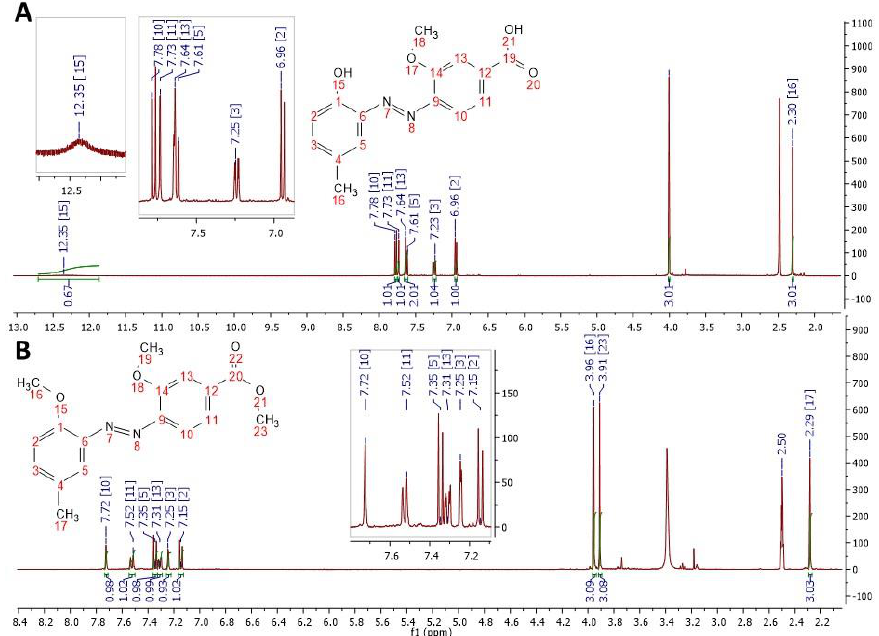
Figure 2. 1 H–NMR spectrum comparison of 4-((2-hydroxy-5-methylphenyl)diazenyl)-3- Figure2. 1 H–NMRspectrumcomparisonof4-((2-hydroxy-5-methylphenyl)diazenyl)-3-methoxybenzoic methoxybenzoic acid (AZO1) and methyl-3-methoxy-4-((2-methoxy-5-methylphenyl)diazinyl) acid (AZO1) and methyl-3-methoxy-4-((2-methoxy-5-methylphenyl)diazinyl) benzoate (AZO2): benzoate (AZO2): A ) and B ), respectively. ( A ) and ( B ), respectively.